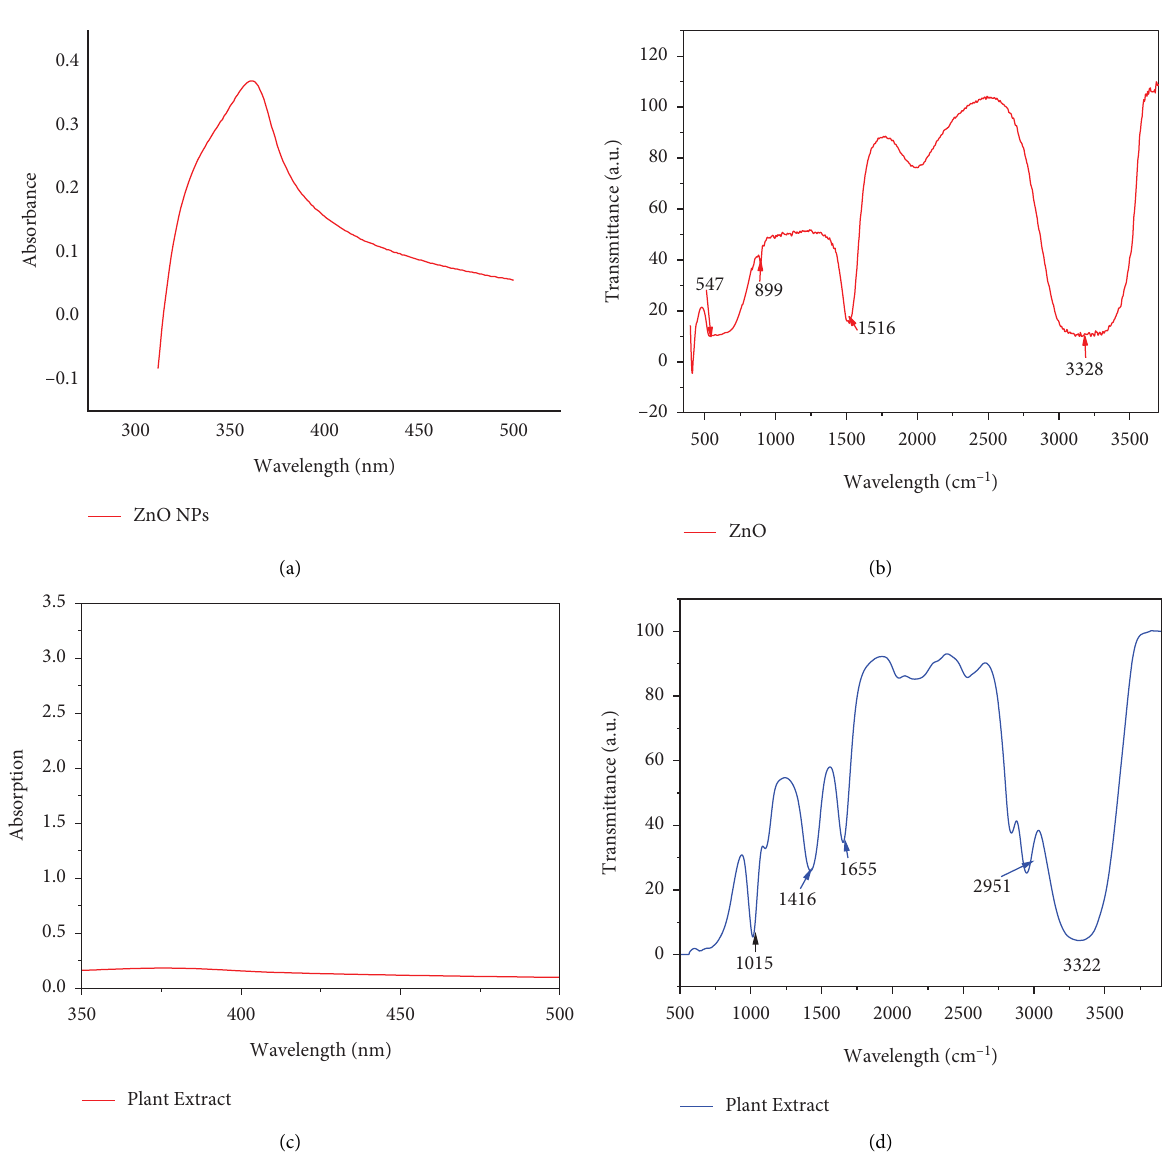
Figure 3: UV-Vis (a, c) and FTIR spectra (b, d) of synthesized ZnO NPs and plant extracts,